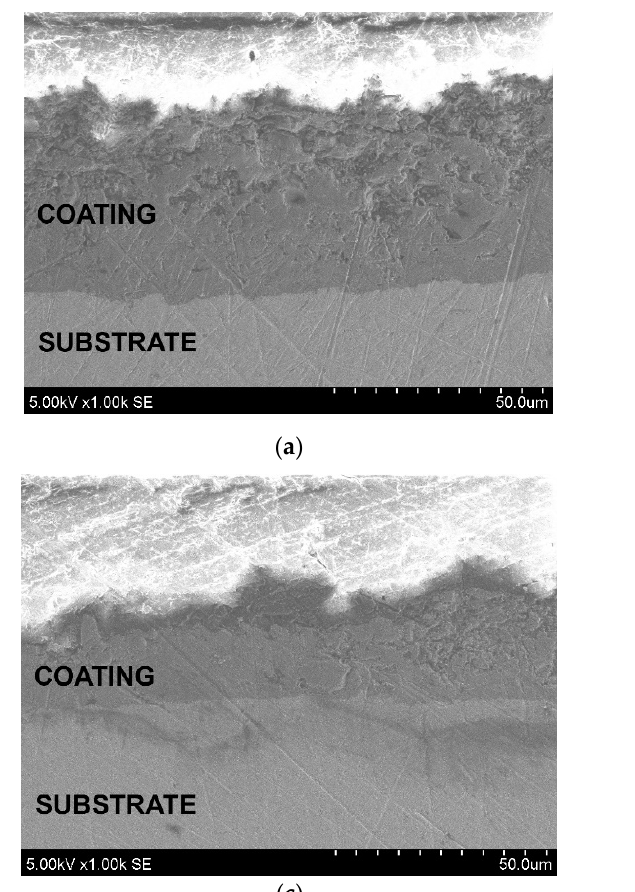
Table 2. Elemental composition and mean square roughness of alumina coatings.